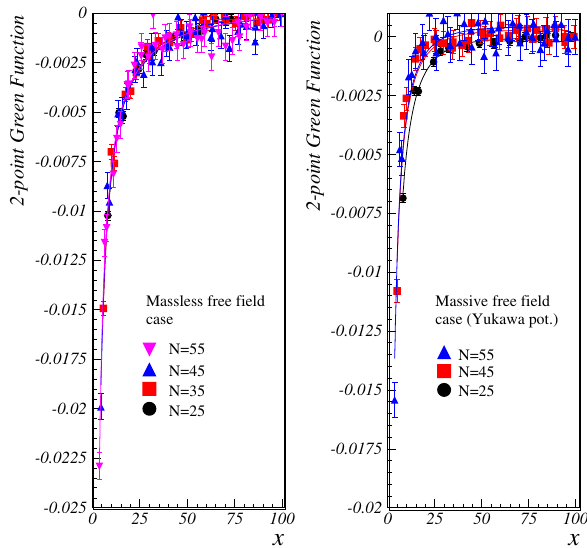
Fig. 15 Verification that G 2 p calculated numerically is invariant with respect to changing the lattice spacing units. In the left panel , the massless free-field case ( L = ∂φ∂φ ) is shown. The case for L = ∂φ∂φ + m 2 φ 2 (Yukawa potential) is shown on the right panel . Statis- tics are N s = 5000 for results with N = 25 , N s = 4000 for massless free-field results with N = 35 and N s = 2000 for the other results. A decorrelationparameterof N cor = 10 hasbeenused. Amass m = 0 . 05 has been used for the Yukawa potential. The lines are the best fits to the data points using the expected functional forms 1 / x and e − mx / x for the massless and massive cases, respectively. Their color matches the s y mbol colors